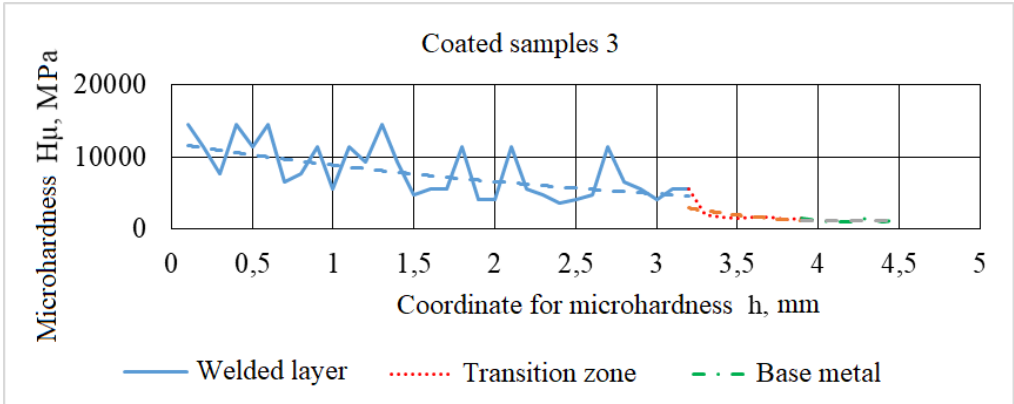
Fig. 7. Microhardness of the sample coated with the composition Fe-Cr-Mo-V-C - 10% chromium, 1% molybdenum, 1% vanadium, 0.8% carbon